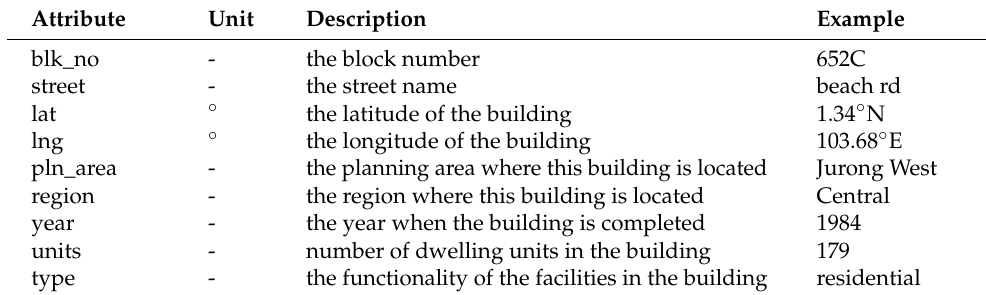
Table 5. Attribute list of the HDB